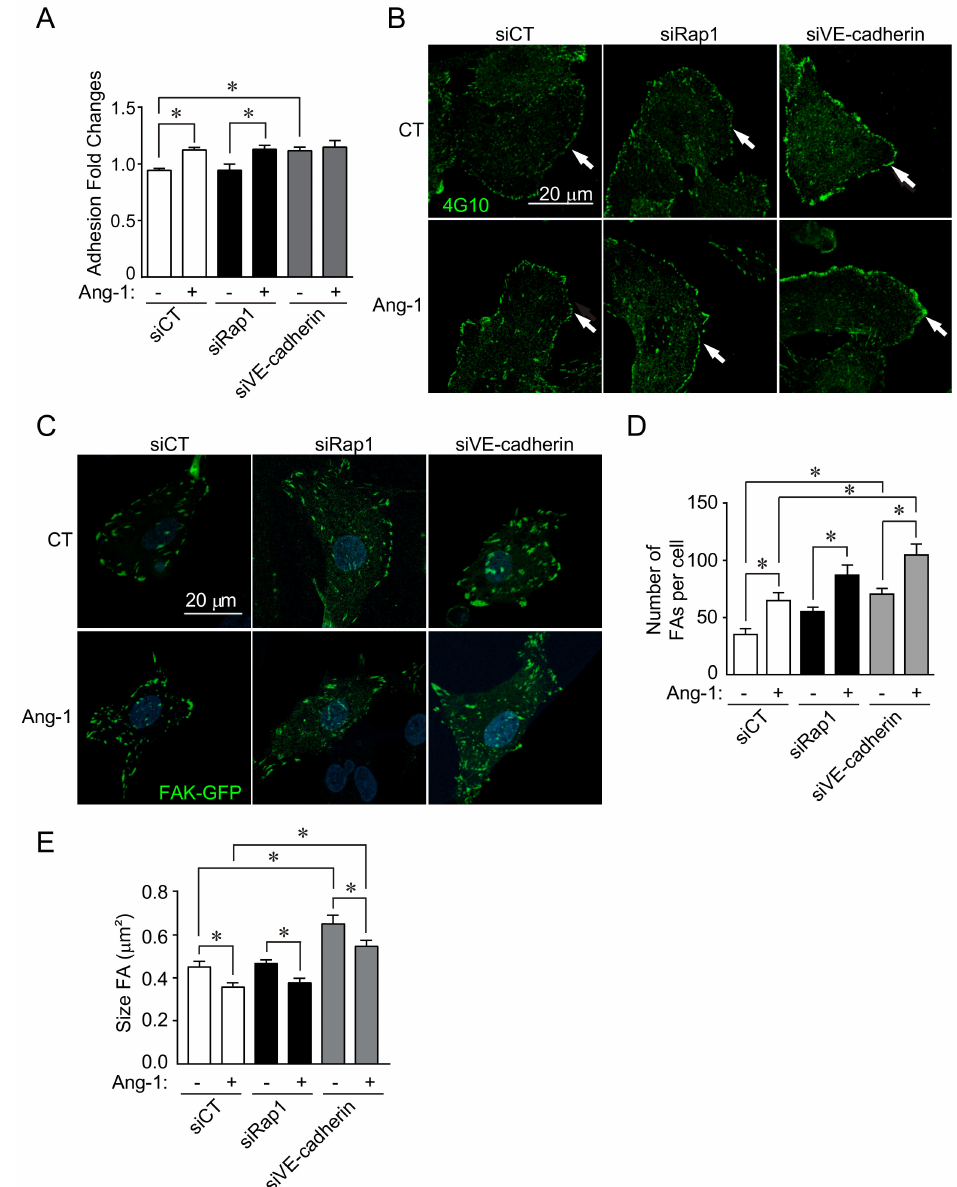
Figure 5. VE-cadherin required for Ang-1-induced cell adhesion to extracellular matrix. ( A ) Quantification of relative cell adhesion to gelatin-coated substrates of BAECs transfected with siRNA against VE-cadherin (siVE-cadherin), Rap1 (siRap1), or control siRNA (siCT), as indicated. Adhesion assays were performed in absence or presence of Ang-1 (100 ng / mL). Results shown as relative ratio to untreated and siCT-transfected cells. ( B ) Representative confocal micrographs of BAECs stained for total phosphotyrosine (4G10; green) and transfected with siCT, siVE-cadherin, or siRap1. Where indicated, cells were stimulated with Ang-1 (100 ng / mL) for 30 min prior to fixation. Arrows point towards cell membrane where phosphotyrosine staining was strongest. Scale bar: 20 µ m. ( C ) Representative confocal micrographs images of BAECs transfected with GFP-FAK plasmids and transfected with siCT, siVE-cadherin, or siRap1. Where indicated, cells were stimulated with Ang-1 (100 ng / mL) for 30 min prior to fixation. ( D , E ) Quantification of number of focal adhesions (FAs) per cell and FA size in cells shown in C . Total of five cells per condition were counted. Graphs are representative of three independent experiments each yielding similar results; * p <